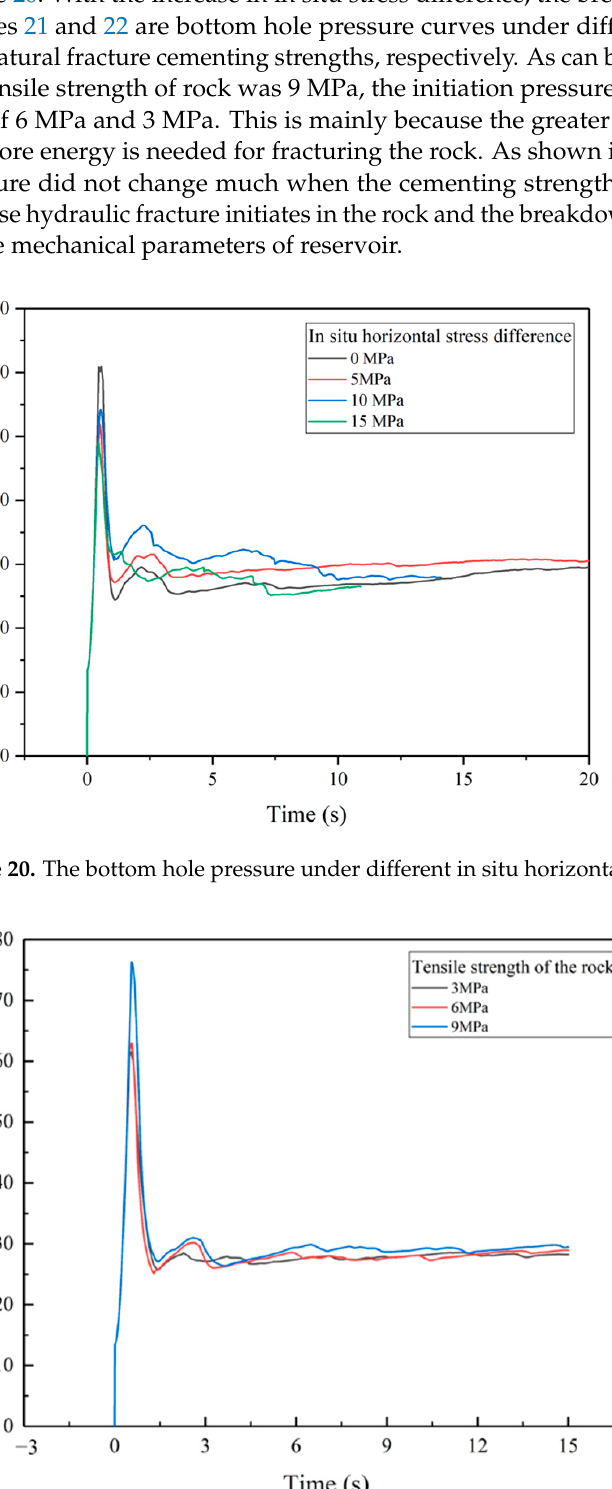
Figure 20. With the increase in in situ stress difference, the breakdown pressure decreased.